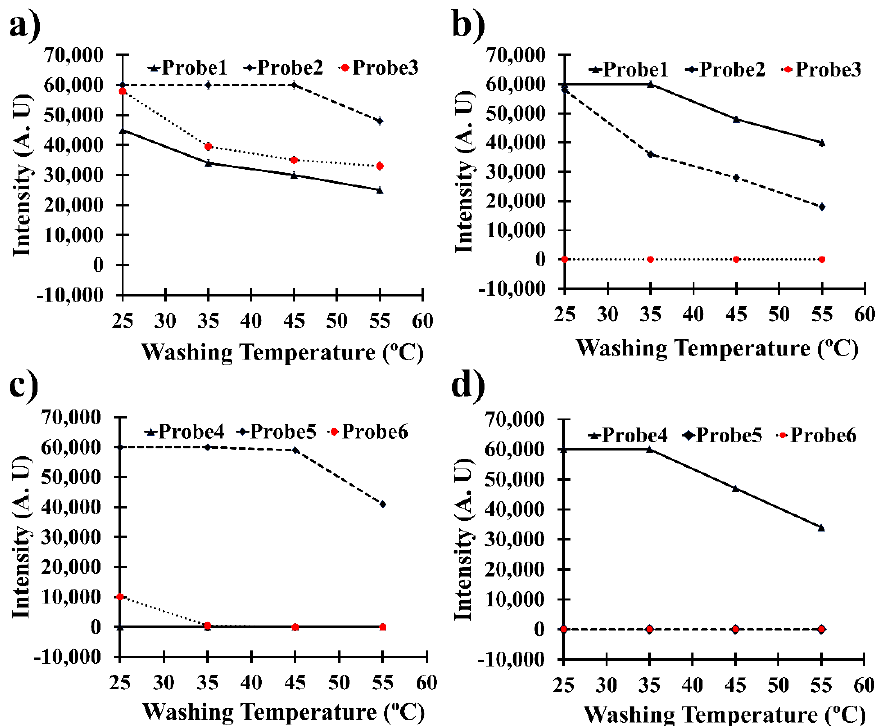
Figure 1. Hybridization of the immobilized probes with complementary Cy5 ‐ ssDNA targets of ( a , c ) Probe2 and ( b , d ) Probe1 at 25 °C, and washing at various temperatures (25, 35, 45, and 55 °C).